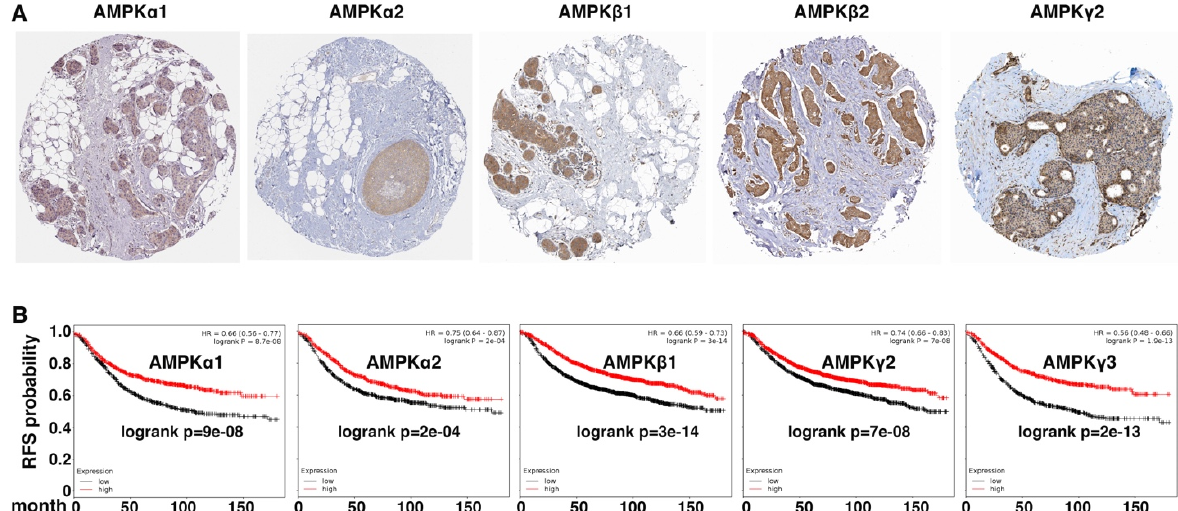
Figure 4. AMPK expression is enriched in epithelial cells in human cancers and is a prognostic indicator. ( A ) Immunohistochemistry analysis of indicated AMPK subunits in human breast tumor arrays. Data were from Human Protein Atlas (www.proteinatlas.org, accessed on 20 May 2022). ( B ) Kaplan–Meier survival was analyzed based on expression levels of AMPK genes in large cohorts of human breast cancer patients using online software (http://kmplot.com/analysis/, accessed on 20 May 2022). Log-rank p values are shown. Low and high expression of the indicated genes is represented by black and red, respectively. RFS: relapse-free survival.